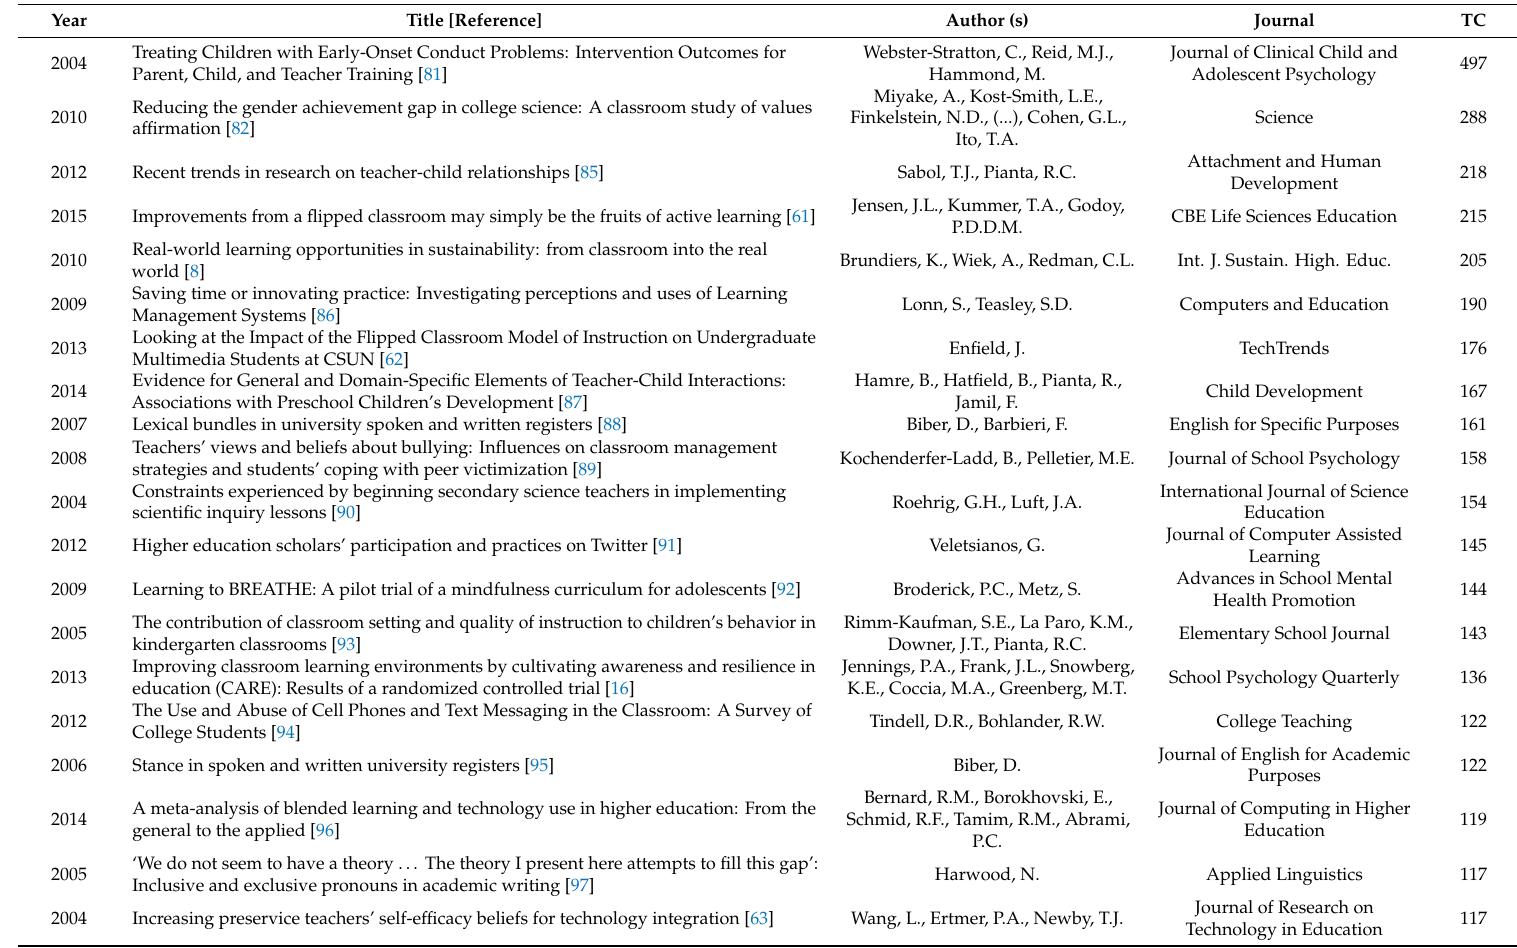
Table 3. Most cited articles on the impact of the university classroom on managing of the socio-educational well-being